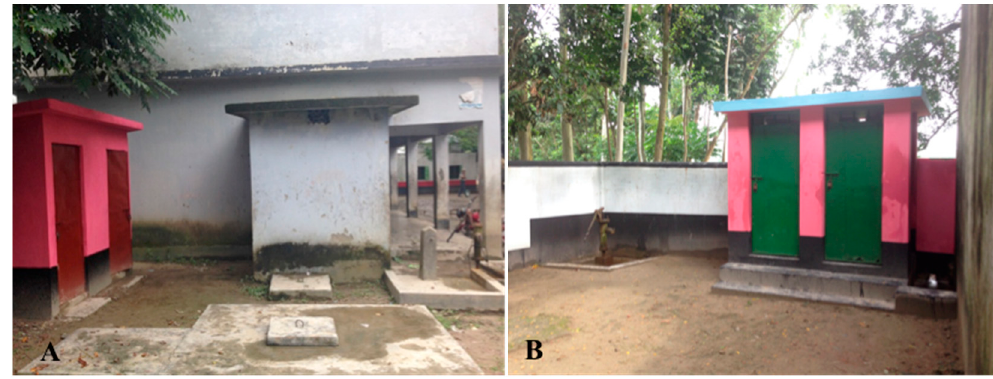
Figure 1. School latrine and water infrastructure prior to nudges in School ( A ) and School ( B ).